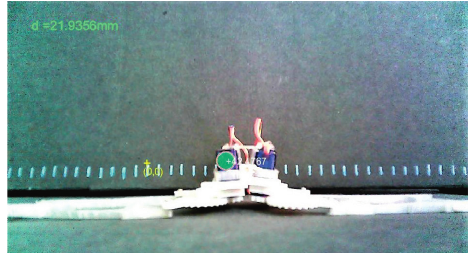
Figure 15: Display of the distance traveled from an